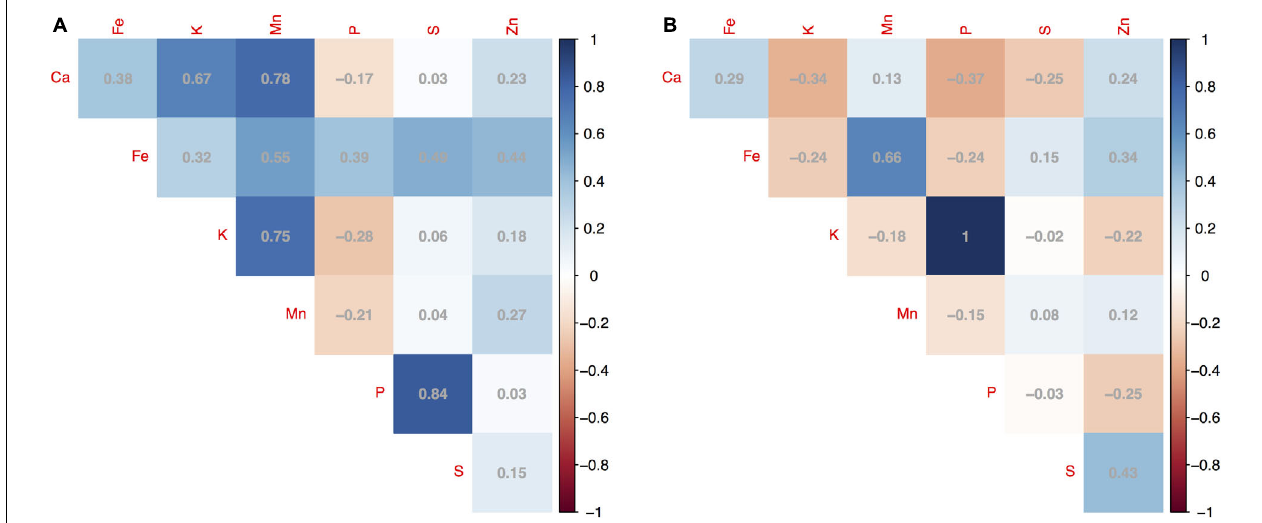
FIGURE 2 | Pairwise correlation coefficients ( R 2 ) for concentrations of seven seed minerals measured for 95 mung bean ( Vigna radiata ) genotypes harvested across 2 years showing (A) correlations between minerals in 2015; and (B) between the same minerals in 2016. The magnitude of significance shown with a gradient color